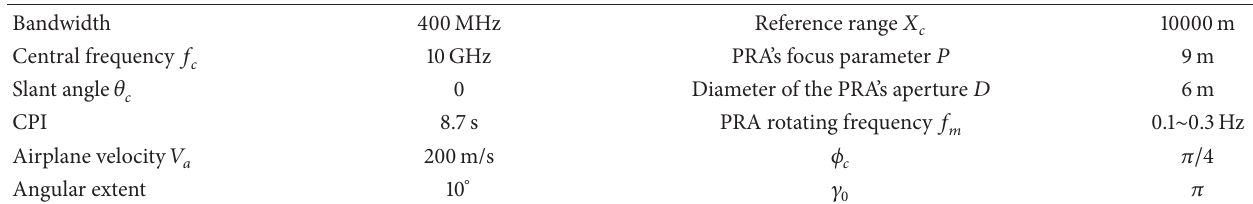
Figure 8: 2D images of the PRA in a turntable, by CBP, using GRECO data. (a) 𝜃 󸀠 ∈ [88 ∘ , 92 ∘ ] ; (b) 𝜃 󸀠 ∈ [0 ∘ ,180 ∘ ] . Table 1: SAR and RPRA’s